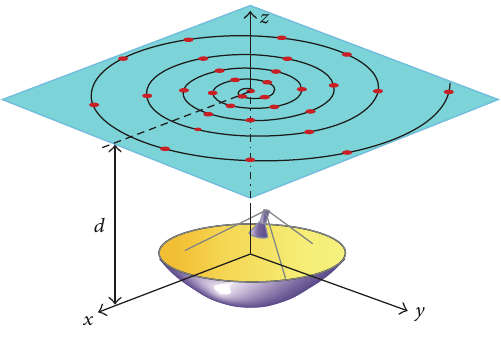
Figure 1: Helicoidal scanning.